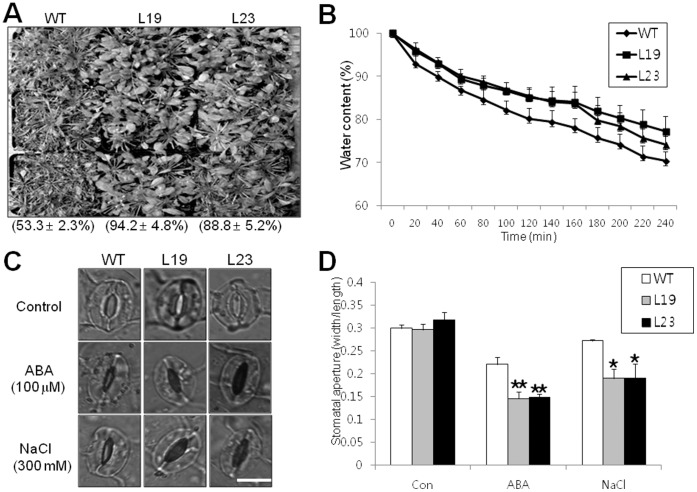
Overexpression of VrUBC1 enhances drought tolerance and stomatal closure in response to ABA and osmotic stress in Arabidopsis.(A) Four-week-old, soil-grown wild-type and 35S:VrUBC1 Arabidopsis transgenic plants were kept in a growth chamber without watering for 14 d. Photographs were taken 3 d after rewatering. (B) Differential transpiration water loss between the wild-type and the 35S:VrUBC1 Arabidopsis transgenic plants. Detached leaves from 3- to 4-week-old plants grown on soil were incubated at room temperature and fresh weight (FW) was measured at the time intervals indicated. Water content was calculated from percentage of FW compared with weight at zero time. Error bars, mean ± SD of three replicates. (C) Stomatal aperture of the wild-type and 35S:VrUBC1 Arabidopsis transgenic plants. Stomatal guard cells were observed by light microscopy in epidermis from wild-type and 35S:VrUBC1 Arabidopsis transgenic plants treated with NaCl (300 mM) and ABA (100 µM) for 3 h. Bar = 10 µm. (D) Measurement of stomatal aperture of wild-type and 35S:VrUBC1 Arabidopsis transgenic plants. Data are mean ratios of width to length ± SD of three independent experiments (n = 60).